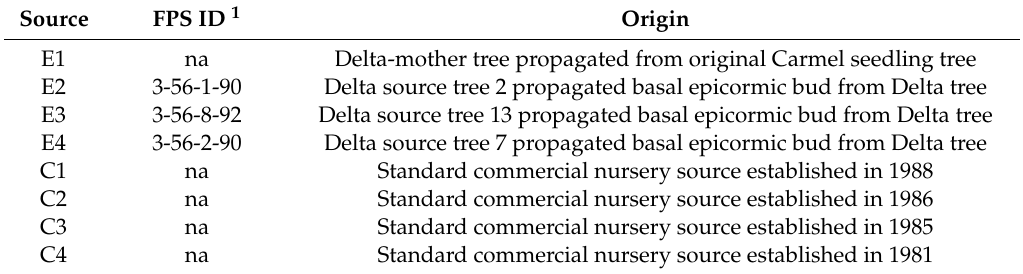
Table 1. Carmel almond propagation sources.